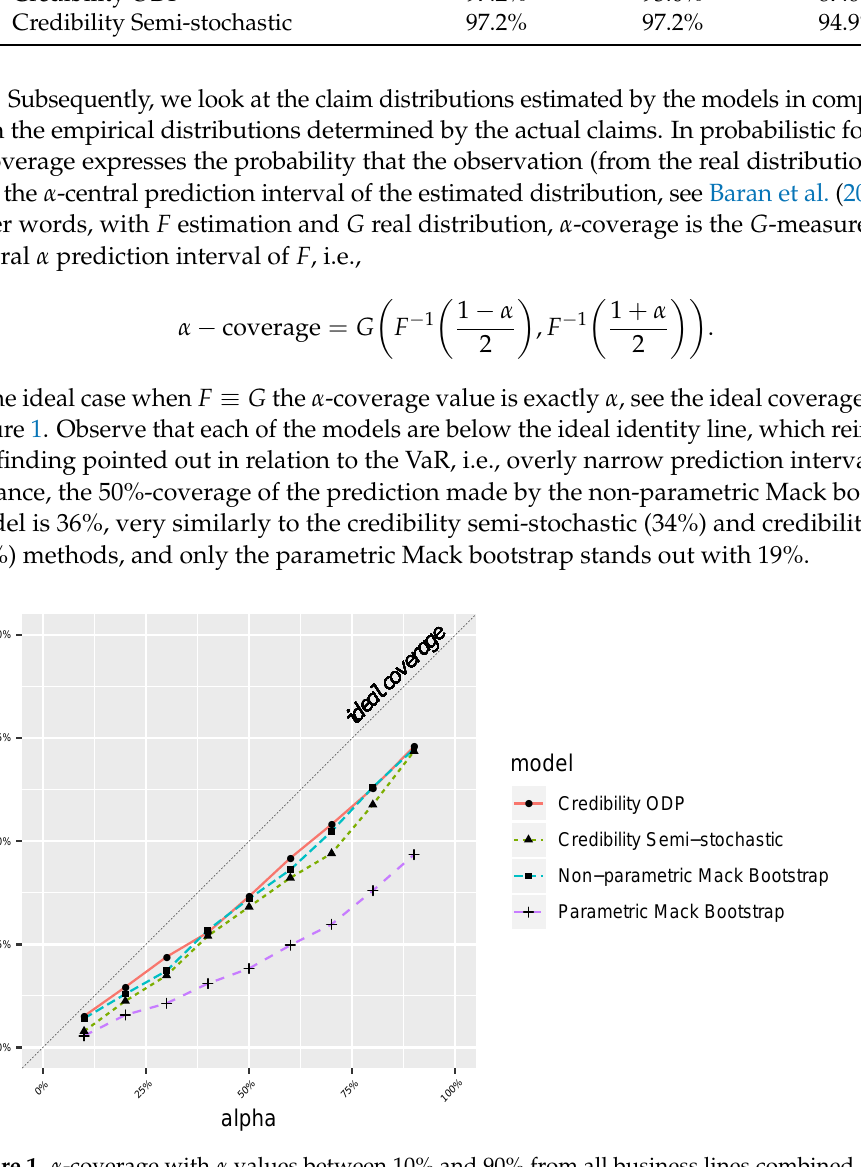
Figure 1. α -coverage with α values between 10% and 90% from all business lines